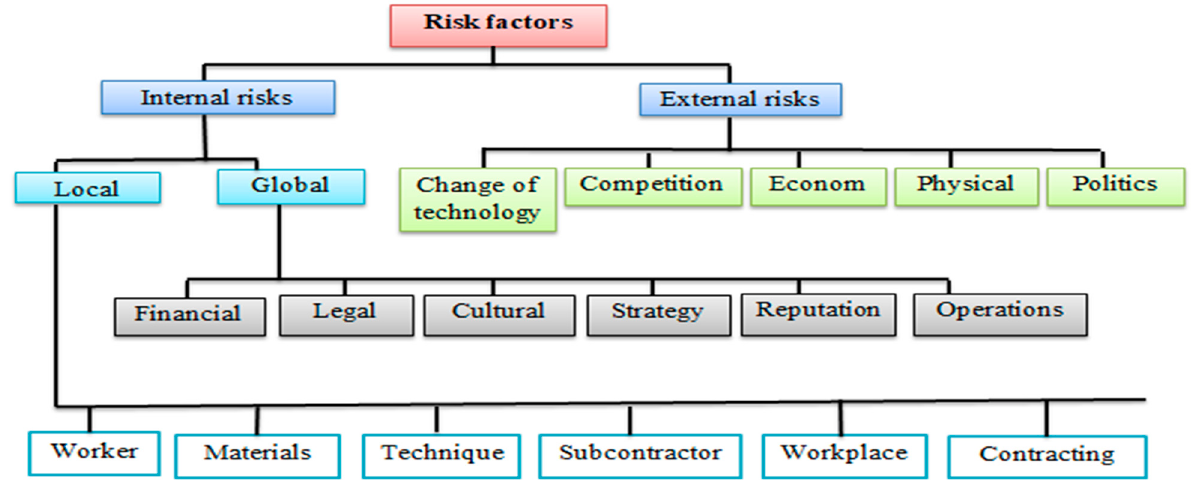
Figure 1. External and internal risk factors affecting the activities of construction enterprises.